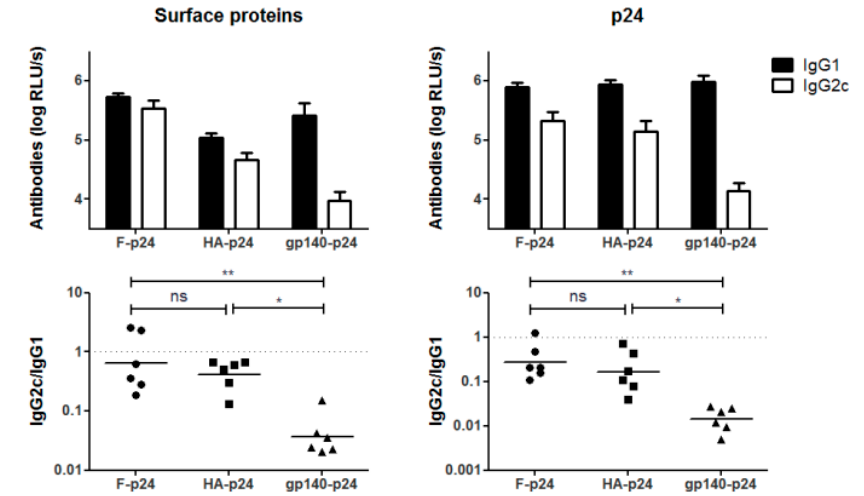
Figure 5. Biased immune responses to HIV Env in C57Bl6 mice. C57Bl/6J mice were immunized with the plasmids F-p24, HA-p24 and gp140-p24. The levels of IgG1 and IgG2c specific for the respective surface antigen (left) or the internal p24 (right) were determined by ELISA (top) and the IgG2c/IgG1 ratios were calculated for each individual animal represented by the symbols (bottom). The bars represent the mean values with SEM (top), whereas the lines represent the geometrical mean for each vaccine group (bottom). ( n = 6; * p < 0.05, ** p < 0.01, ns = not significant, Kruskal-Wallis-test with Dunn’s post-test).